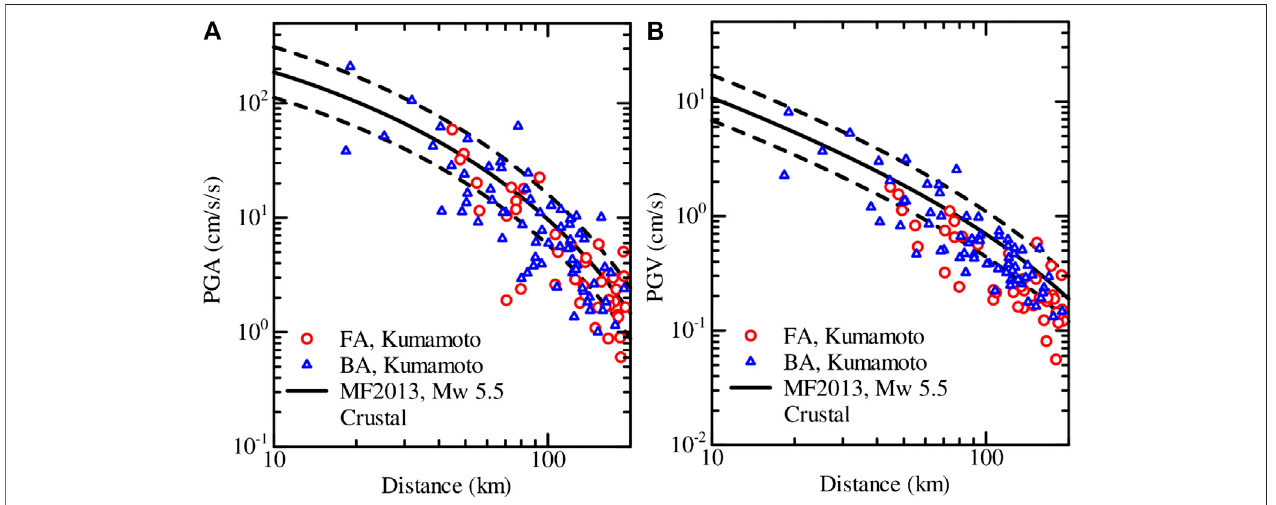
FIGURE 14 | Same as in Figures 13A,B for the northeast Kumamoto earthquake, but here the data are grouped into the fore-arc (FA) and back-arc (BA) regions. See the text for further explanation.